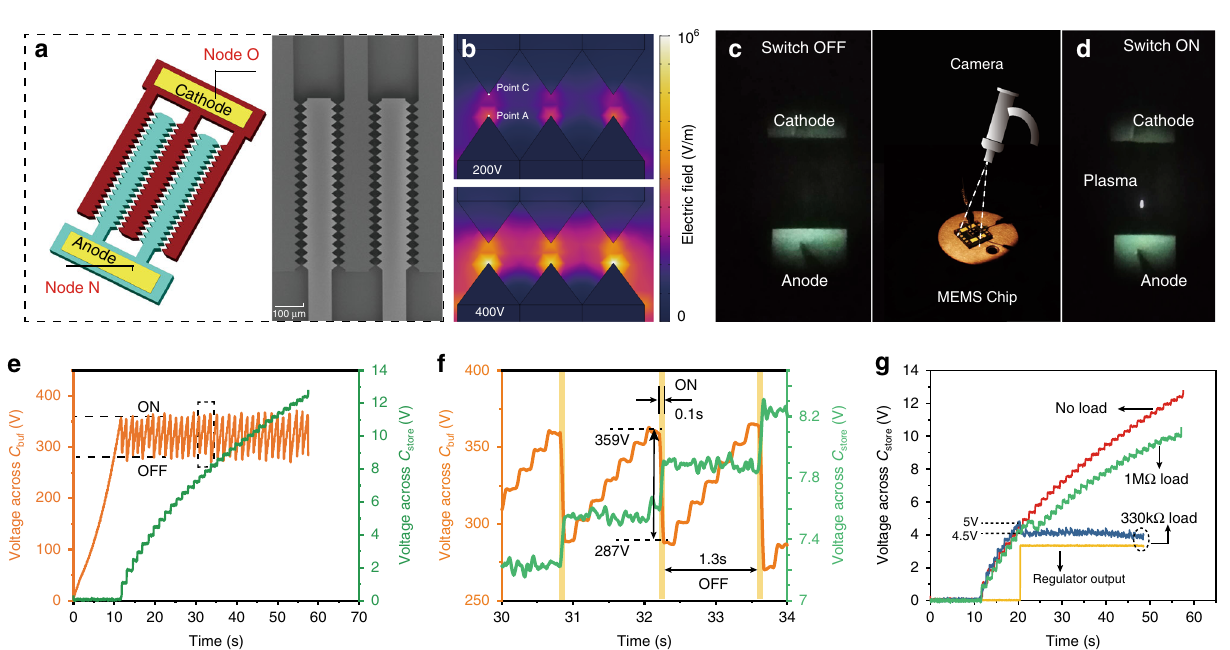
Fig. 3 MEMS fi xed plasma switch and its electrical characteristics. a Schematic and SEM image of the MEMS fi xed plasma switch. b The simulated electric fi eld of three tips with voltages of 200 V and 400 V between the anode and the cathode. c Photo of the switch in the OFF state. d Photo of the switch in the ON state. The fi gure between c , d shows the MEMS chip and the setup to capture the plasma discharge. e The output voltage across C buf and C store when using the fi xed switch ( a ) in the 2-stage circuit without any regulator nor load. f A detail of the output voltage in e between 30 s and 34 s. g Comparisons of the voltages across C store with different loads. Source data are provided as a Source data fi